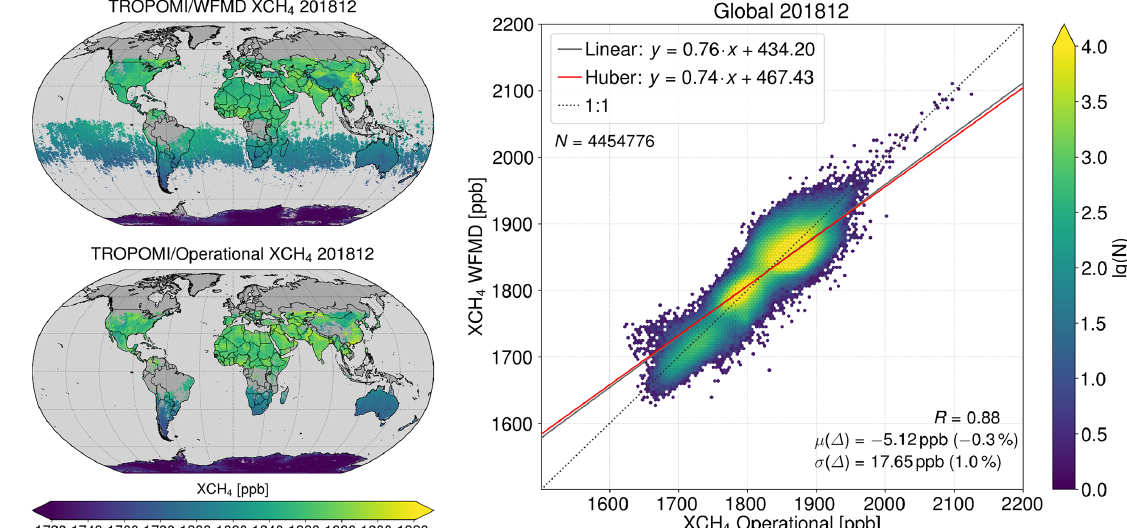
Figure 16. As Fig. 15 but for methane.